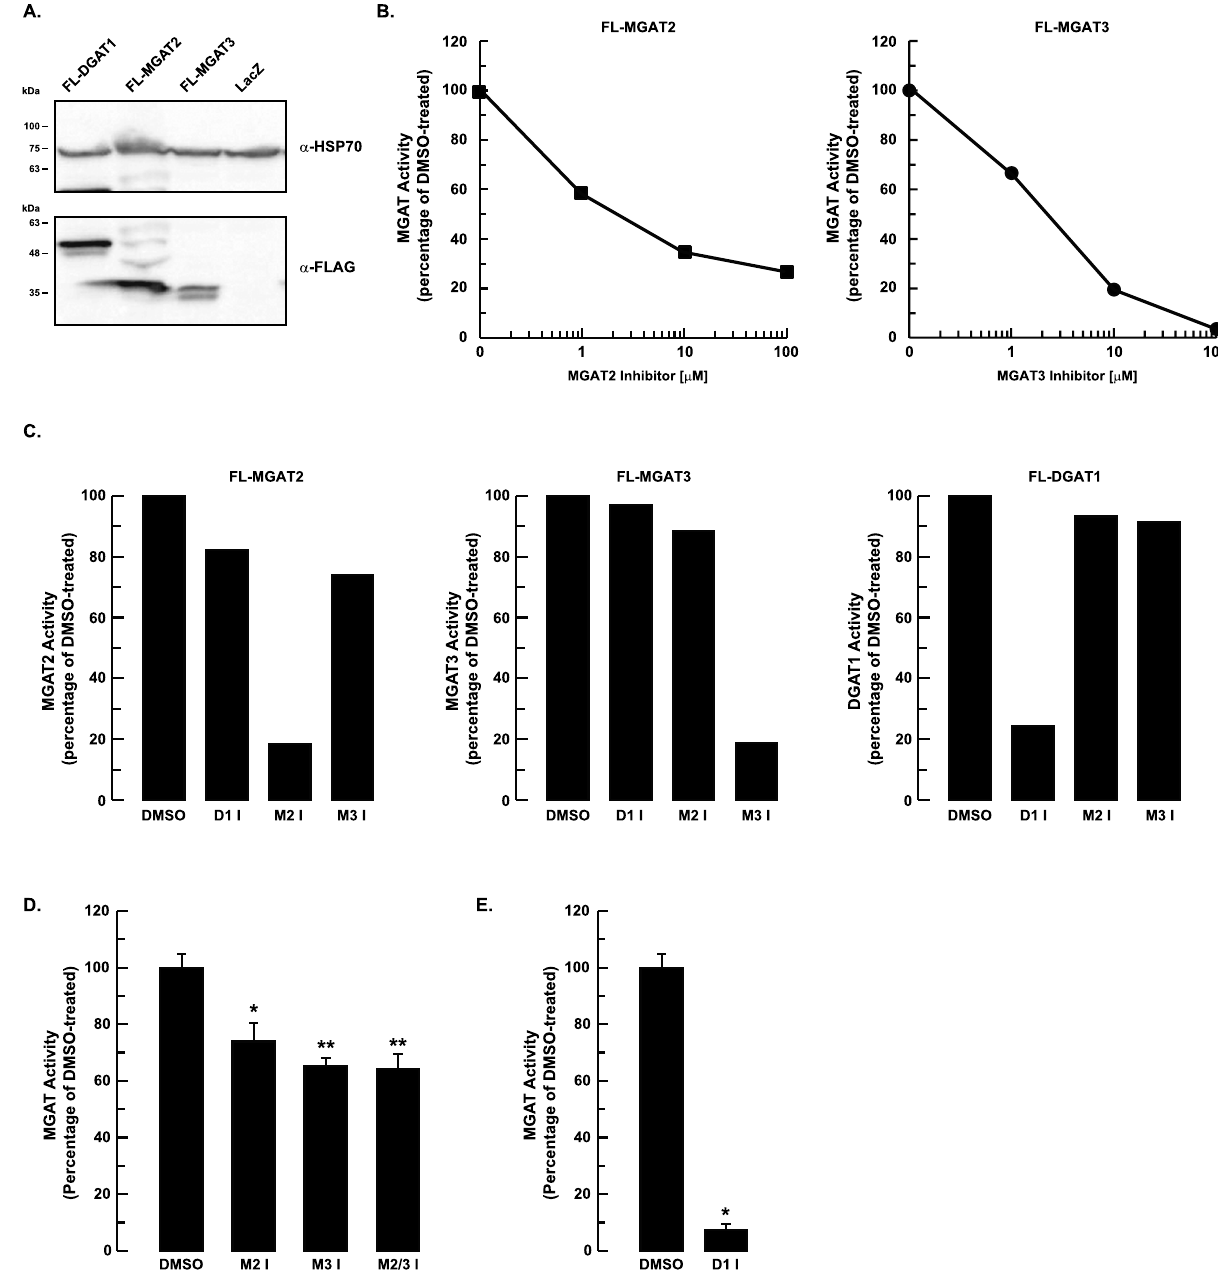
Figure 1. Pharmacological inhibition of MGAT2, MGAT3 and DGAT1. ( A ) Overexpression of FL-MGAT2, FL-MGAT3 and FL-DGAT1 in HEK-293T cells. Crude mitochondrial membrane fractions isolated from HEK- 293T cells expressing FL-MGAT2, FL-MGAT3 or FL-DGAT1 were separated by SDS-PAGE and immunoblotted with anti-FLAG (α-FLAG) and anti-mitochondrial HSP70 (α-HSP70) antibodies. An uncropped image is shown in Supplementary Fig. 1. ( B ) The samples described in ( A ) were preincubated for 30 min with either the MGAT2 or MGAT3 inhibitors at the indicated concentrations. MGAT activity was determined and compared to control (DMSO-treated) samples. ( C ) Crude mitochondrial membrane fractions from HEK-293T cells expressing FL-MGAT2, FL-MGAT3 or FL-DGAT1 were preincubated for 30 min with either 25 µM MGAT2, 50 µM MGAT3 or 5 µM DGAT1 inhibitors. MGAT activity was determined and compared to control (DMSO- treated) samples. ( D ) Crude mitochondrial membrane fractions from HepG2 cells were pre-incubated with the MGAT inhibitors (10 µM) as described in Fig. 1C, separately or together. MGAT activity was determined and was normalized to control (DMSO-treated) cells. * p < 0.01 and ** p < 0.001 versus DMSO-treated cells. ( E ) Inhibition of DGAT1 reduces MGAT activity in HepG2 cells. Crude mitochondrial membranes from HepG2 cells were pre-incubated with the DGAT1 inhibitor (2 µM final concentration) for 1 h. MGAT activity was determined and was normalized to control (DMSO-treated) samples. * p < 0.0001 versus DMSO-treated cells (unpaired two-tailed Student’s t test). D1 I, DGAT1 inhibitor; M2 I, MGAT2 inhibitor; M3 I, MGAT3 inhibitor; M2/3 I, MGAT2 and MGAT3